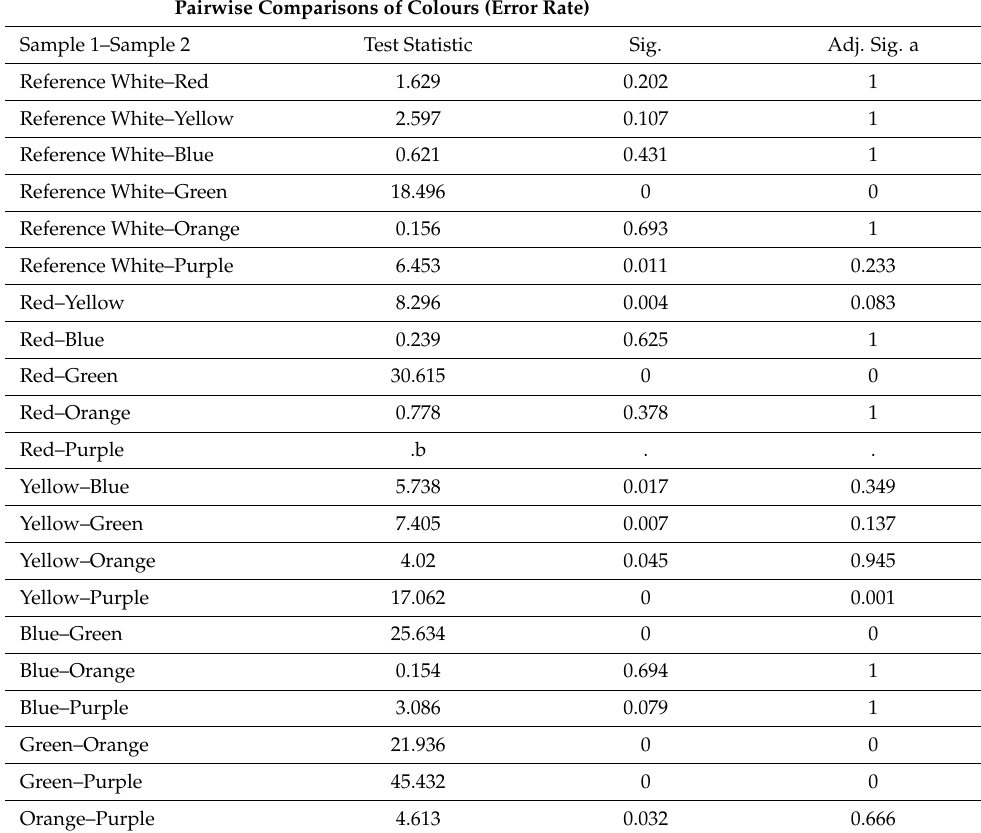
Table A3. Effects on error rate (general effects).